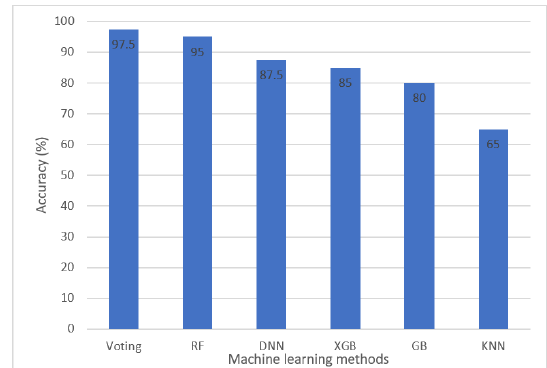
Fig. 4. The comparison of the classification performance of the classifiers in terms of their accuracy